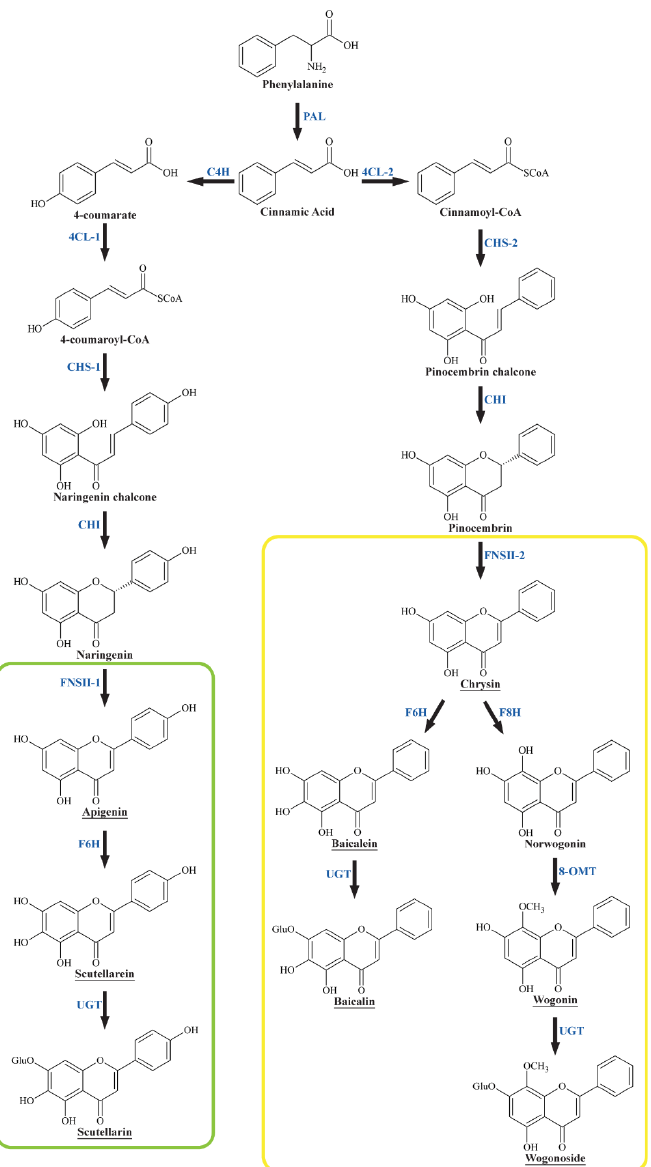
Figure 1. Flavone biosynthetic pathway in Scutellaria baicalensis based on (Zhao et al., 2016). Under- lined flavones have been quantified by HPLC in this study. Flavones encircled in green (left) indicate 4’-hydroxyflavones of interest. Flavones encircled in yellow (right) indicate 4’-deoxyflavones of interest. Listed enzymes are phenylalanine ammonia lyase (PAL), cinnamate 4-hydroxylase (C4H), cinnamate-coA ligase (4CL 1-2), chalcone synthase (CHS 1-2), chalcone isomerase (CHI), flavone syn- thase II (FNSII 1-2), flavone 6-hydroxylase (F6H), flavone 8-hydroxylase (F8H), 8-O-methyl transferase (8-OMT), and UDP-glucuronosyl transferase